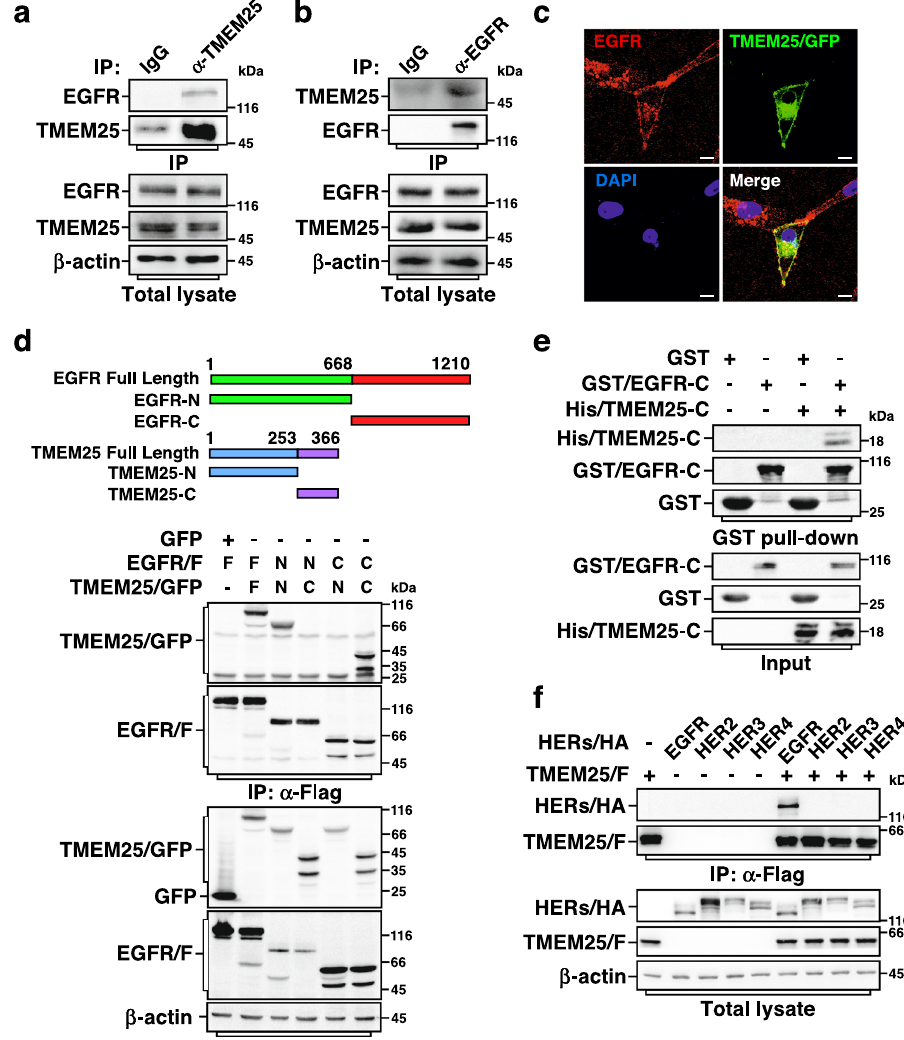
Fig. 1 | TMEM25 interacts with EGFR. a, b TMEM25 interacts with EGFR endo- genously. Cell lysates from MDA-MB-231 cells were subjected to anti-TMEM25 IP followed by immunoblotting to detect associated EGFR ( a ) or to anti-EGFR IP fol- lowedbyimmunoblottingtodetectassociatedTMEM25( b ). c TMEM25colocalizes with EGFR at plasma membrane. MDA-MB-231 cells transfected with C-terminal green fl uorescentprotein(GFP)-taggedTMEM25(TMEM25/GFP)weresubjectedto immuno fl uorescence assay to detect localization of TMEM25/GFP (green) and endogenous EGFR (red). The nuclei were stained with DAPI (blue). The scale bars indicate 10 μ m. d TMEM25 interacts with EGFR via both extracellular domain and cytosolic domain. HEK293T cells transfected with indicated combinations of full length (F), N-terminal extracellular/transmembrane domains (N), or cytosolic domain (C) of TMEM25/GFP and C-terminal Flag-tagged EGFR (EGFR/F) were